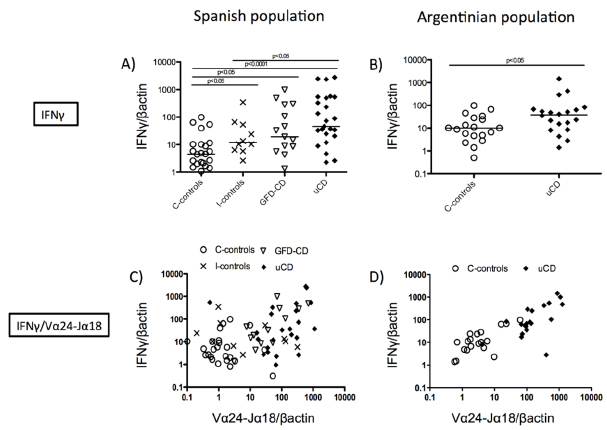
Figure 3. Correlation between duodenal mRNA expression of V α 24 ‐ J α 18 and IFN γ . Expression levels of IFN γ mRNA in duodenal biopsies indicated as the ratio IFN γ / β actin, in arbitrary units (AU), in untreated Celiac Disease (uCD), Gluten Free Diet ‐ CD patients (GFD ‐ CD), inflamed non ‐ CD controls (I ‐ controls) and non ‐ inflamed non ‐ CD controls (C ‐ controls) in the Spanish population ( A ) and in uCD and C ‐ controls in the Argentinian population ( B ). Statistically significant differences are shown (two tailed Mann ‐ Whitney U test; Krustall ‐ Wallis test). Horizontal bars are median values. Correlation between the expression of IFN γ and V α 24 ‐ J α 18 mRNA, in arbitrary units (AU) in the Spanish population ( C ) (C ‐ controls: Spearman r = 0.3115, p value = n.s; I ‐ controls: Spearman r = 0.4265, p value = n.s; GFD ‐ CD: Spearman r = 0.5393, p value < 0.05; uCD: Spearman r = 0.4323, p value < 0.05) and in the Argentinian population ( D ) (C ‐ controls: Spearman r = 0.5895, p value < 0.05; uCD: Spearman r = 0.6917, p value <